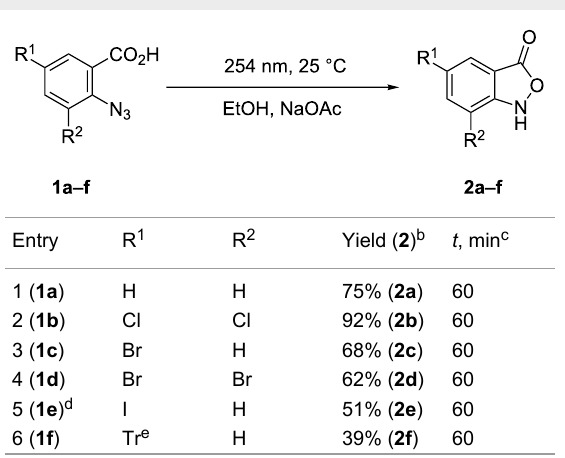
Table 2: Substrate scope for the heterocyclization of 2-azidobenzoic acid.